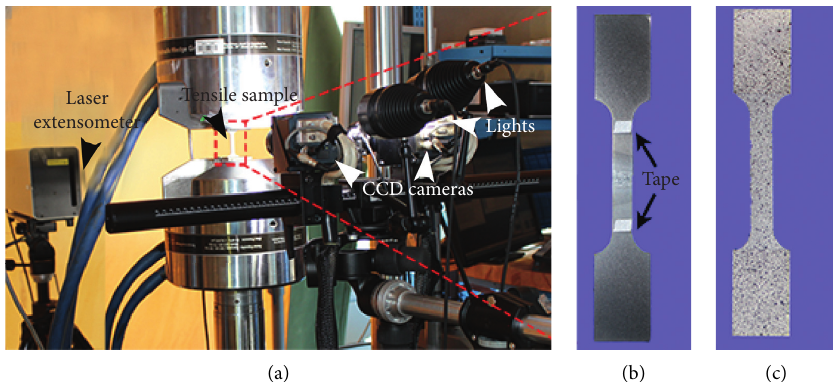
Figure 3: (a) MTS tensile testing configuration showing the position of the laser extensometer relative to the two CCD cameras of the Aramis ® system, (b) etched side of the tensile sample showing the reflective tape applied to demarcate the gage length, and (c) opposite side of the tensile sample that was painted with a speckle